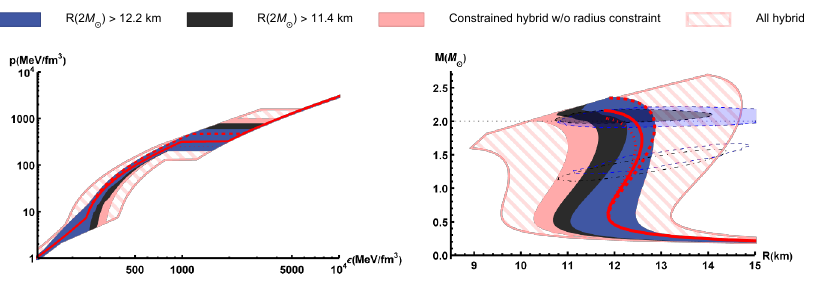
Figure 3. Hybrid V-QCD EOSs at T = 0. Left: the regions spanned by allowed by the allowed EOSs as indicated by the labels. Right: The allowed regions of mass-radius curves. Figures adapted from [53].